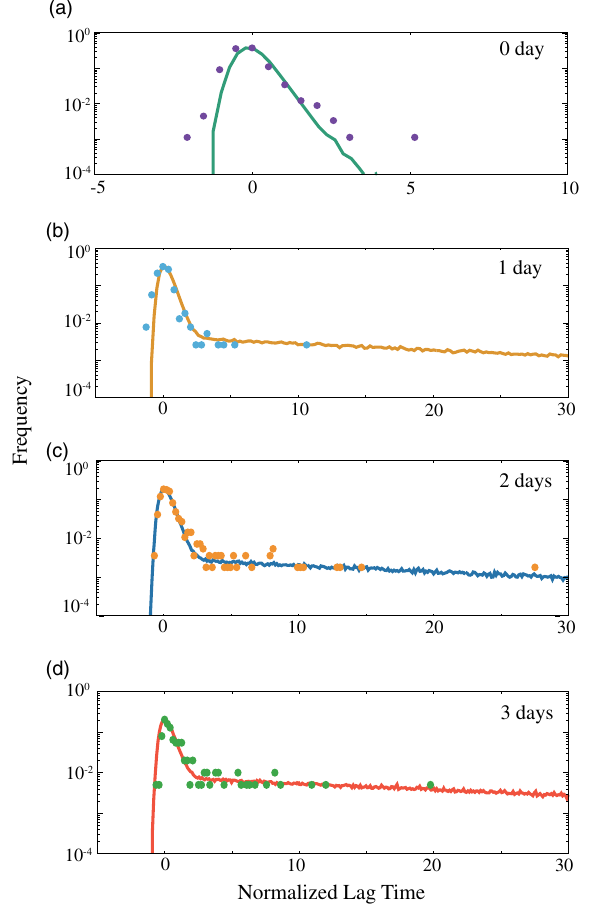
FIG. 5. Distribution of lag time obtained by model simulation (solid line) with experimental data (lag-time distribution of cultures starved for the indicated days) overlaid. The horizontal axis of each distribution was normalized by using its peak point ð Peak Þ and the full width at half maximum (FWHM) as λ → ð λ − Peak Þ = FWHM. Experimental data were extracted from those presented in Fig. 1(e) of Reismann et al. [18]. Methods of stochastic simulations, the procedure used to compute Peak and FWHM, and parameter values are given in Appendix C.